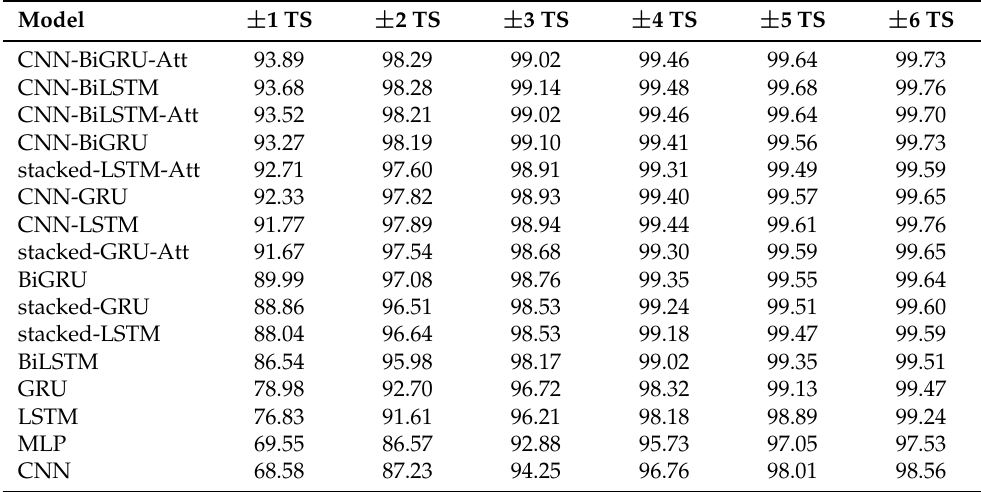
Table 2. Accuracy results for all